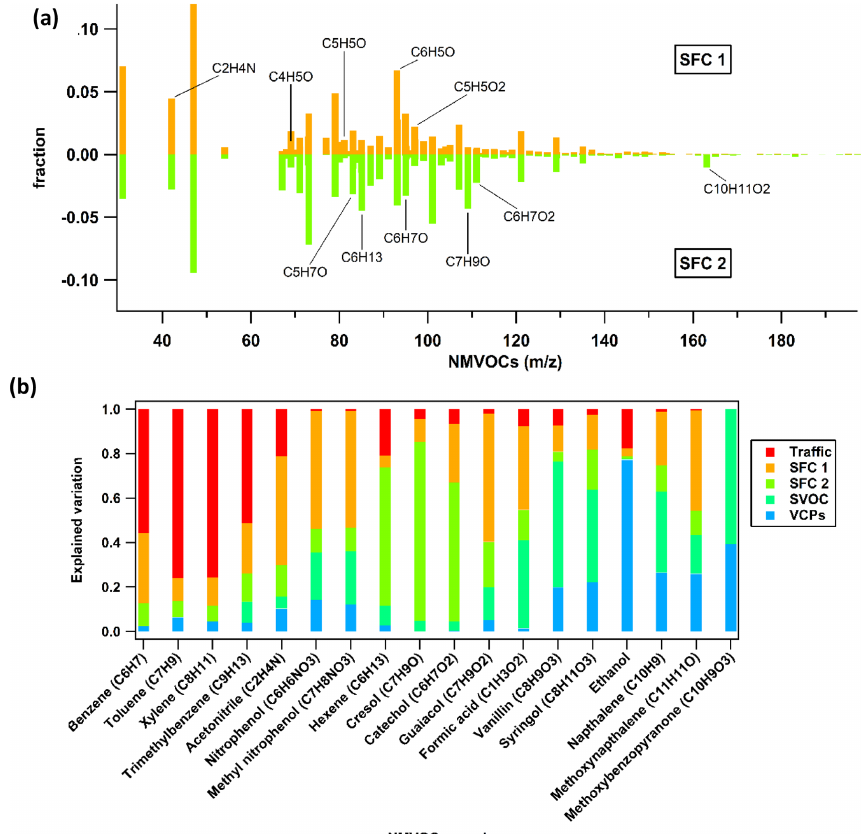
Figure 8. (a) Comparison of the relative composition of two factor profiles (SFC 1 and SFC 2). SFC 1 spectrum on top and SFC 2 spectrum on bottom. (b) Explained variation of selected NMVOC species, stacked such that the total explained variation is 1, colour-coded by the five